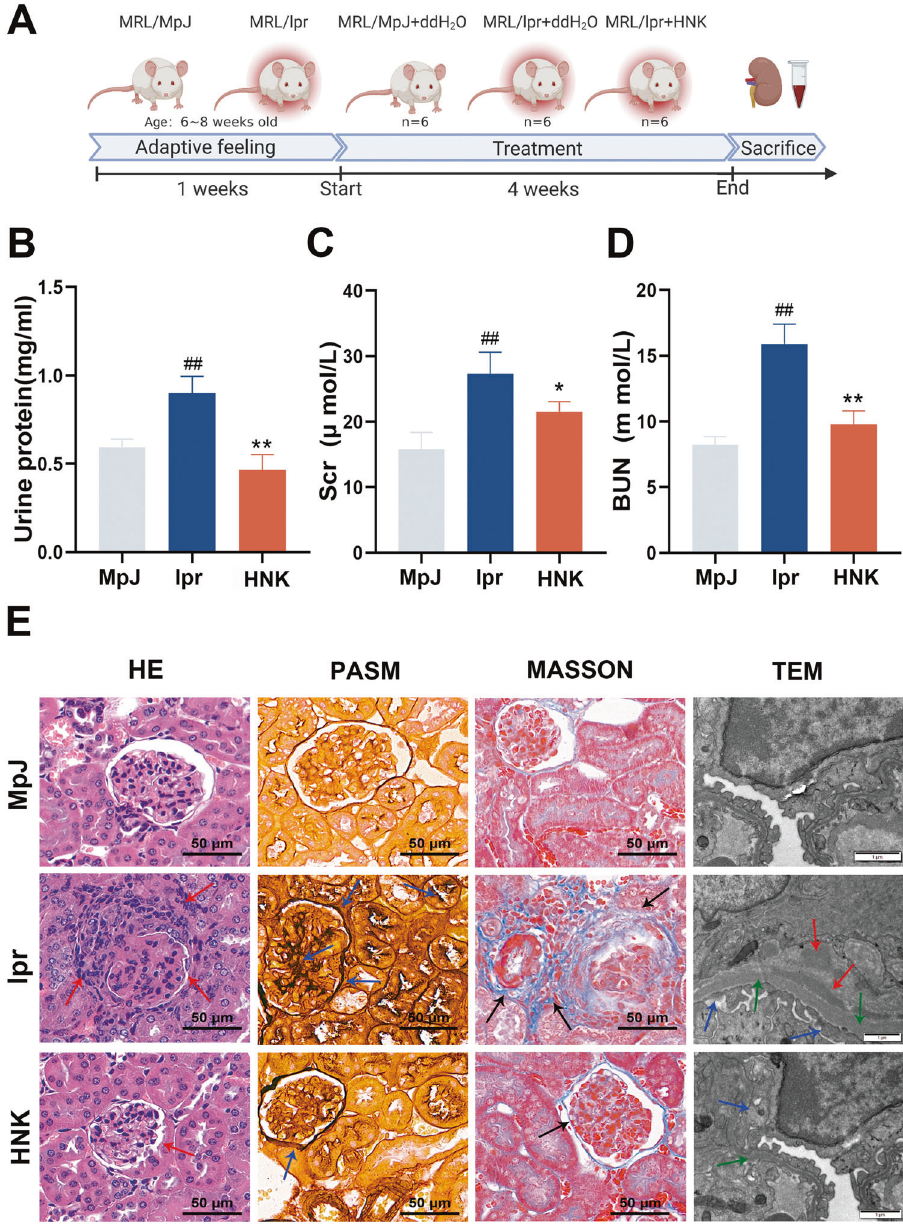
in fl ammatory-cell in fi ltration (hematoxylin-and-eosin staining), glomerular mesangial hyperplasia (periodic acid silver methenamine staining), and mesangial fi brosis (Masson staining); 400×; scale, 50 μ m. The red and blue arrows indicate in fl ammatory cells and intraglomerular mesangial proliferation, respectively. The black arrows indicate collagen fi ber deposition. Shown are representative transmission electron microscopy images. Original magni fi cation 15,000×; scale, 1 μ m ( n = 6, */# p < 0.05, **/## p < 0.01; # versus the MPJ group; * versus the lpr